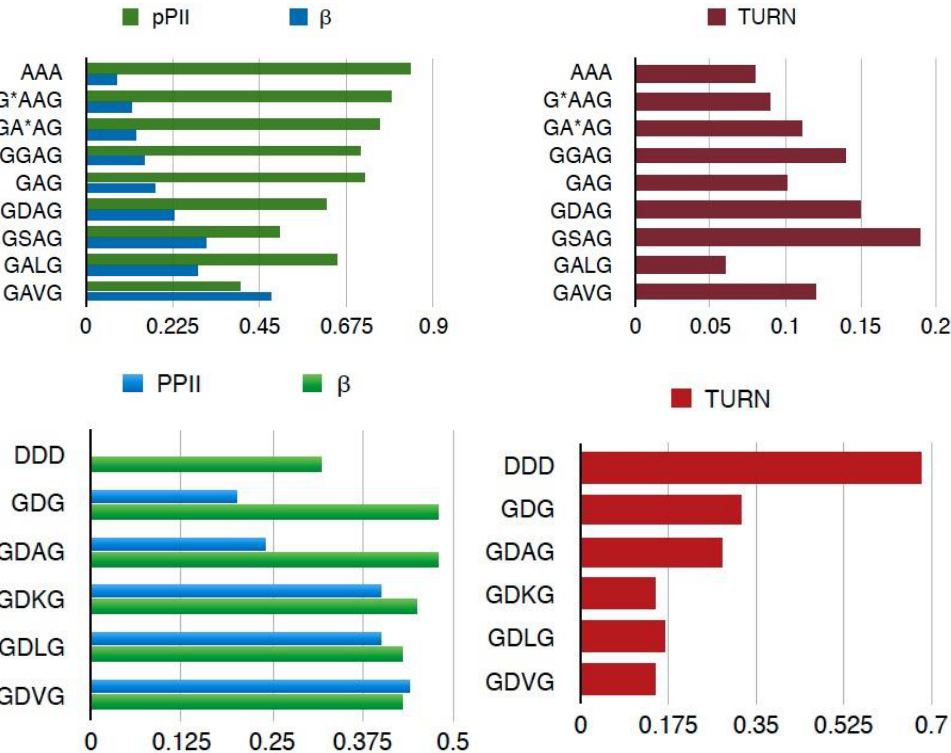
Figure 15. Mole fractions of pPII, β-strand and turn-forming conformation of alanine ( upper panel ) and aspartic acid ( lower panel ) in the indicated tri- and tetrapeptides. The turn fraction was calcu- lated as the sum over the occupation of all non-pPII/β-strand conformations. Note, that the color codes for the two panels are different. Taken from Toal [126].